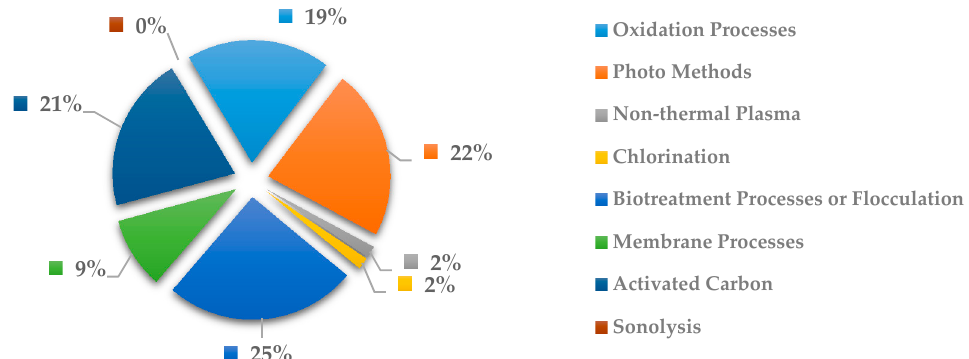
Figure 27. Percentage of scientific articles worldwide regarding wastewater treatments of cardiovascular drugs between 1998 and 2020. Data collected in Scopus database by using wastewater or water as keywords and English as a language limitation.